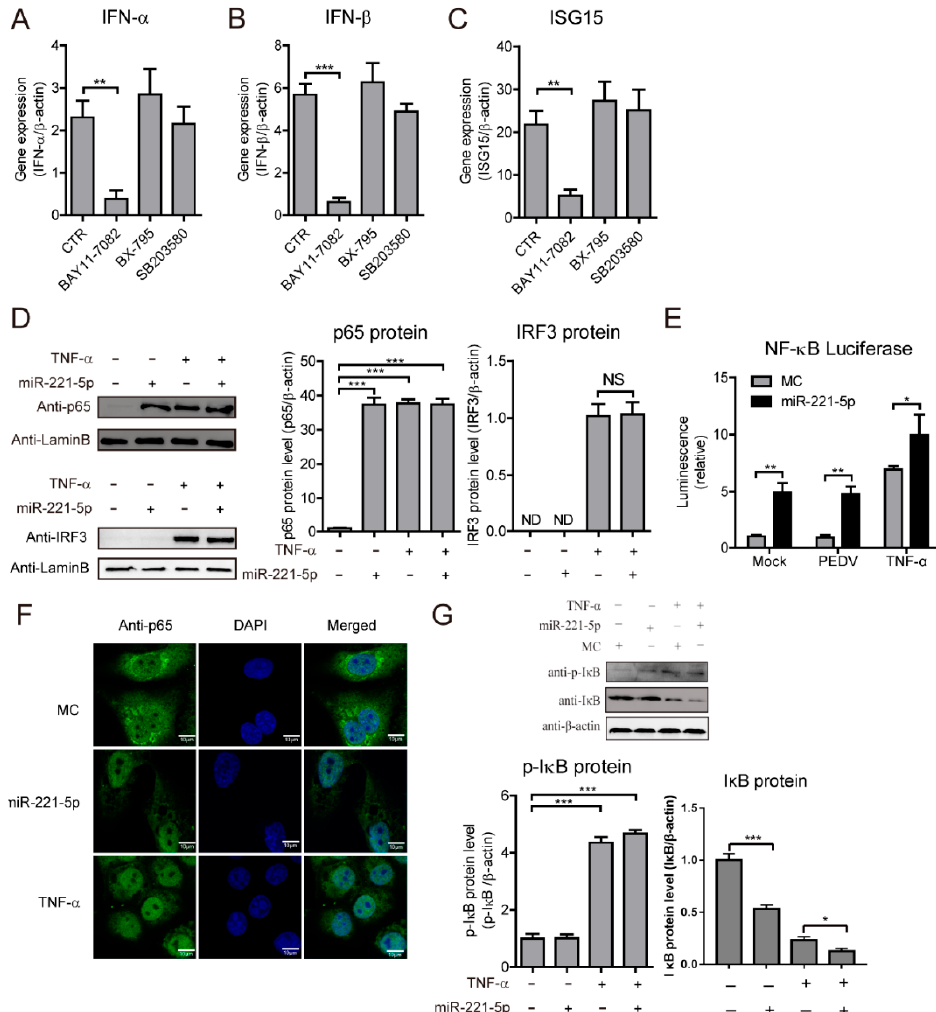
Figure 6. miR-221-5p activates the NF- κ B pathway by increasing p65 nuclear translocation. Real-time qRT-PCR analysis of IFN- α ( A ), IFN- β ( B ), and ISG15 ( C ) mRNA levels (normalized to β -actin expression) in PEDV-infected MARC-145 cells (24 h; CH/HBTS/2017, MOI = 0.1) transfected with 50 nM miR-221-5p mimics or MC for 6 h, followed by treatment with different inhibitors (BAY11-7082, 10 µ M; BX-795, 10 µ M; or SB203580, 50 µ M) for 48 h. Data represent fold changes in the indicated genes relative to MC following miR-221-5p transfection, and are presented as the mean ± SD of three independent experiments and measured in technical duplicate. ( D ) Immunoblot analysis of p65 and IRF3 levels in MARC-145 cells transfected with 50 nM miR-221-5p mimics or MC for 24 h, followed by infection with PEDV CH/HBTS/2017 at an MOI of 0.1 for 24 h. The intensity represents p65 and IRF3 protein levels (right) normalized against that for β -actin across three independent experiments. ( E ) Luciferase activity in MARC-145 cells co-transfected with a dual luciferase-reporter system (PNiFty-luc and pRL-TK, the activities of which indicate NF- κ B-promoter activation) and infected with PEDV CH/HBTS/2017 at an MOI of 0.1 for 6 h, or treated with 15 ng/mL TNF- α for 12 h. ( F ) Immunofluorescence analysis of MARC-145 cells transfected with 50 nM miR-221-5p mimics or MC and infected with PEDV CH/HBTS/2017 at an MOI of 0.1 for 24 h. Cells treated with 15 ng/mL TNF- α for 20 min served as the positive controls. Cells were fixed and stained (DAPI, blue; p65 protein, green). Scale bar = 10 µ m. ( G ) Immunoblot analysis of p-I κ B and I κ B levels in MARC-145 cells transfected with 50 nM miR-221-5p mimics or MC for 24 h and infected with PEDV CH/HBTS/2017 at an MOI of 0.1 for 24 h. Intensities representing p-I κ B and I κ B levels (right) were normalized against that for β -actin across three independent experiments. Comparisons between groups were determined by Student’s t test. * p < 0.05; ** p < 0.01; *** p < 0.001; NS p > 0.5. “+” treated; ” − “ untreated.